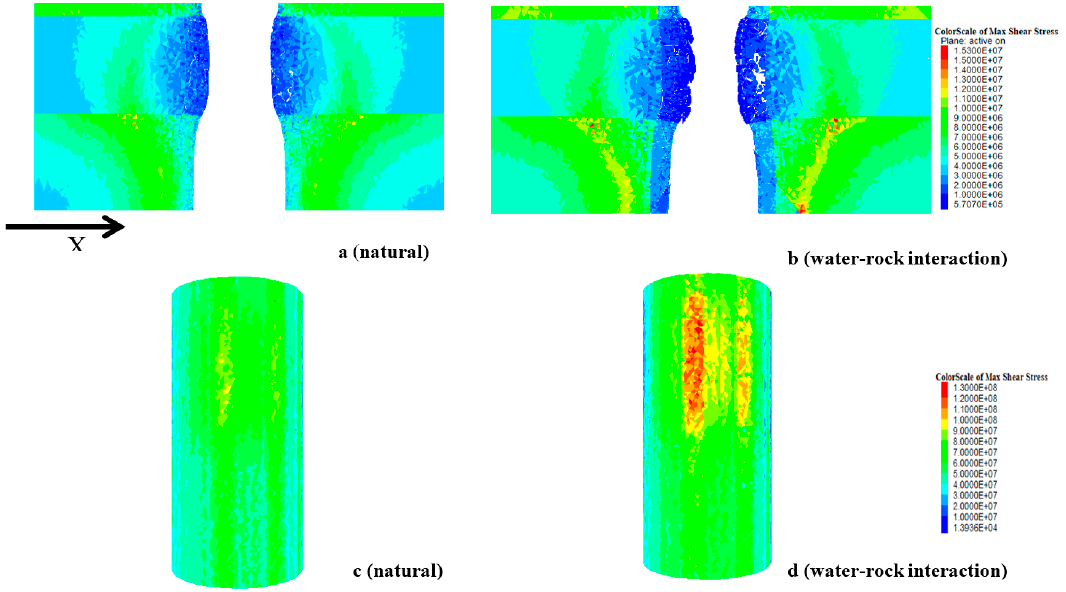
Figure 11. Simulated distribution characteristics of max shear stress under unsupported and concrete supporting conditions.